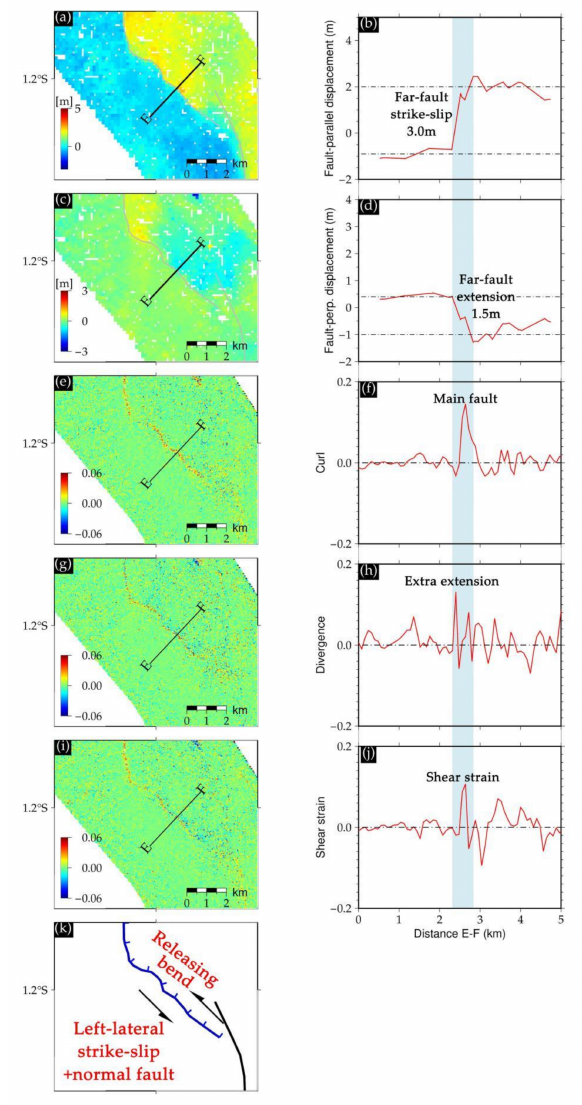
Figure 7. Deformation pattern showing a major releasing bend. ( a ) Fault-parallel displacement field; ( b ) across-fault fault-parallel displacement along profile EF; ( c ) fault-perpendicular displacement field; ( d ) across-fault fault-perpendicular displacement along profile EF; ( e ) curl field; ( f ) curl along profile EF; ( g ) divergence field; ( h ) divergence along profile EF, where increased divergence at the main rupture corresponds to a tensional component; ( i ) shear strain field; ( j ) shear strain along profile EF, where shear strain values at the distributed rupture zone are positive, indicating rupture under predominately left-lateral shear strain; ( k ) characteristics and geometric variation controlling the major releasing bend. The blue stripe denotes the main